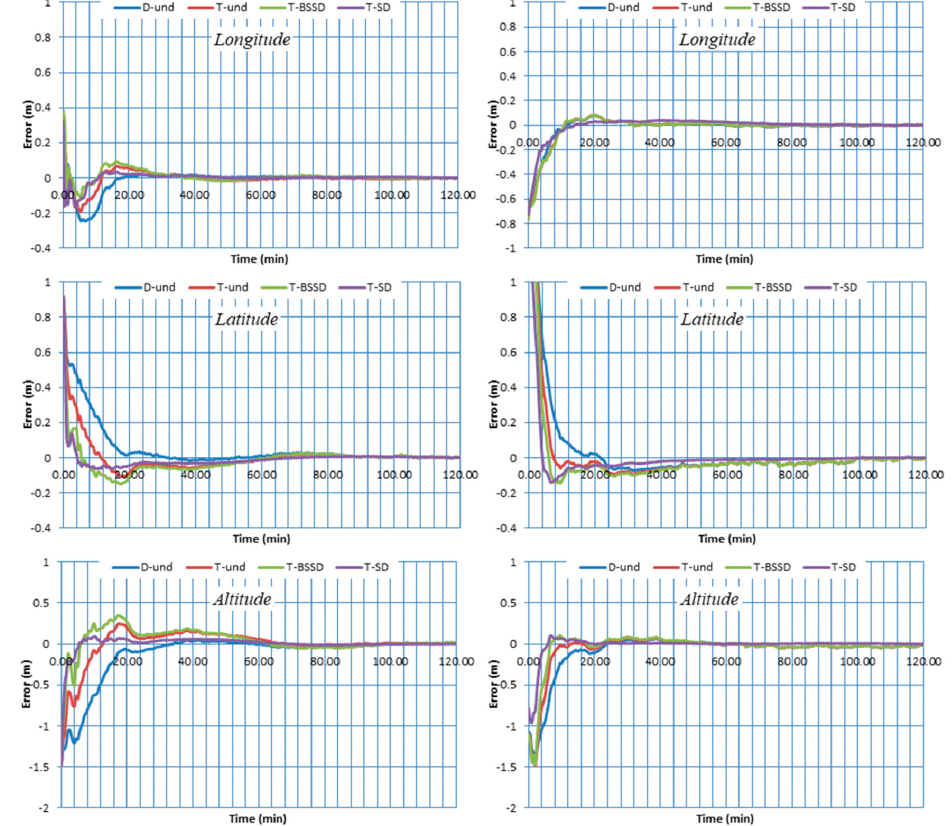
Figure 4. Positioning errors for stations BRST ( left ) and CUT0 ( right ) using different GPS/Galileo PPP models. Figure 4. Maximum and RMSE values of the estimated positioning errors from the PPP